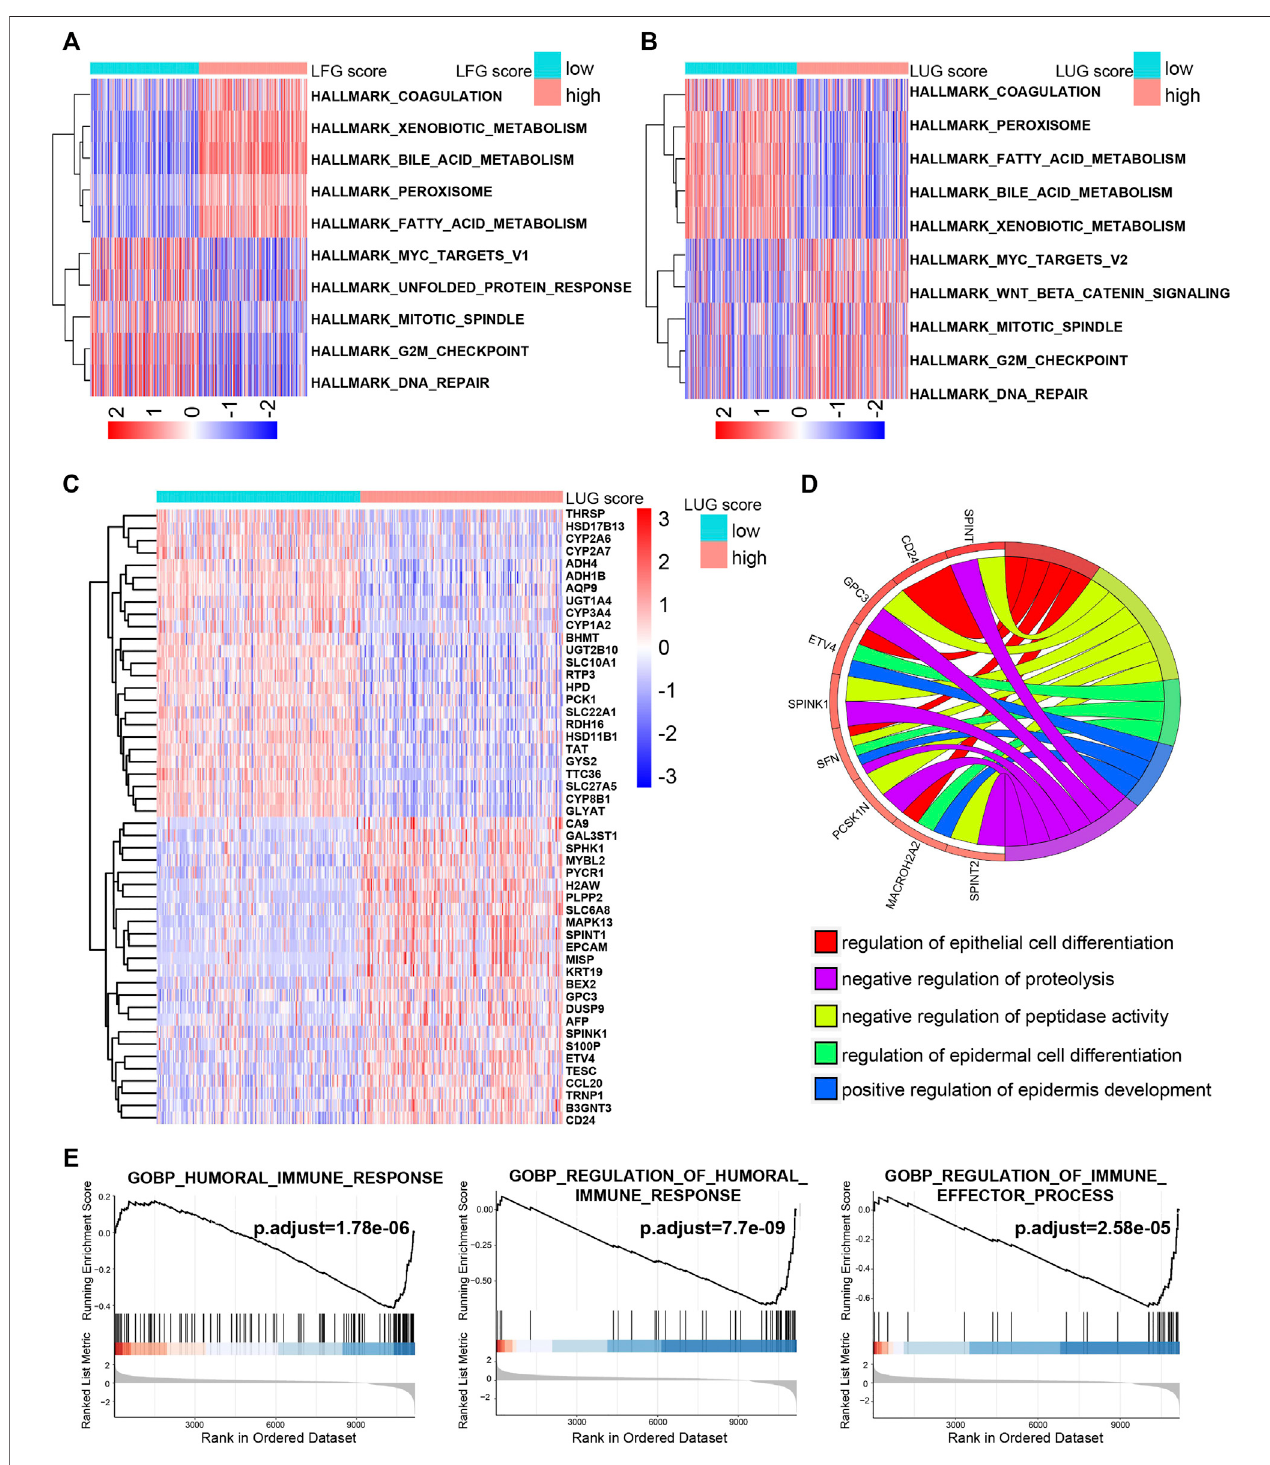
FIGURE 7 | The potential molecular mechanism of the prognostic score. (A , B) GSVA-HALLMARK for LFG score and LUG score. (C) The heatmap of DEGs between high- and low-LUG score groups. (D) GO function annotation of DEGs. (E) GSEA using immune gene set.